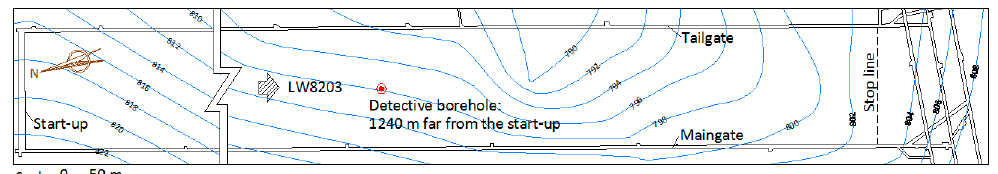
Figure 1. Layout of LW8203 top-coal caving face.